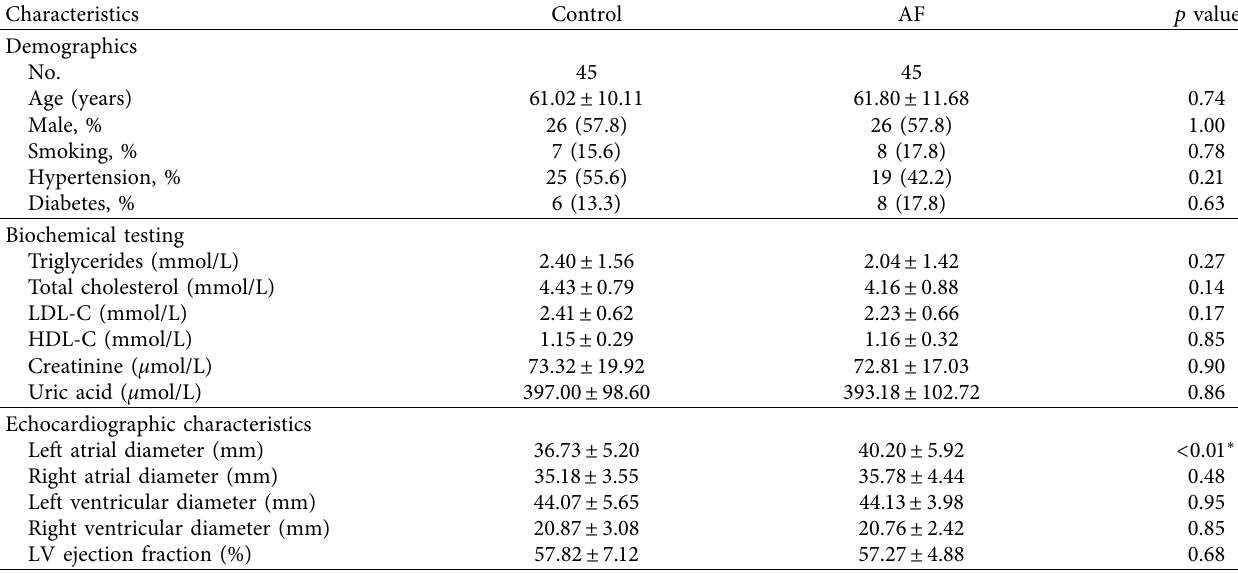
Table 1: Characteristics of the patients.